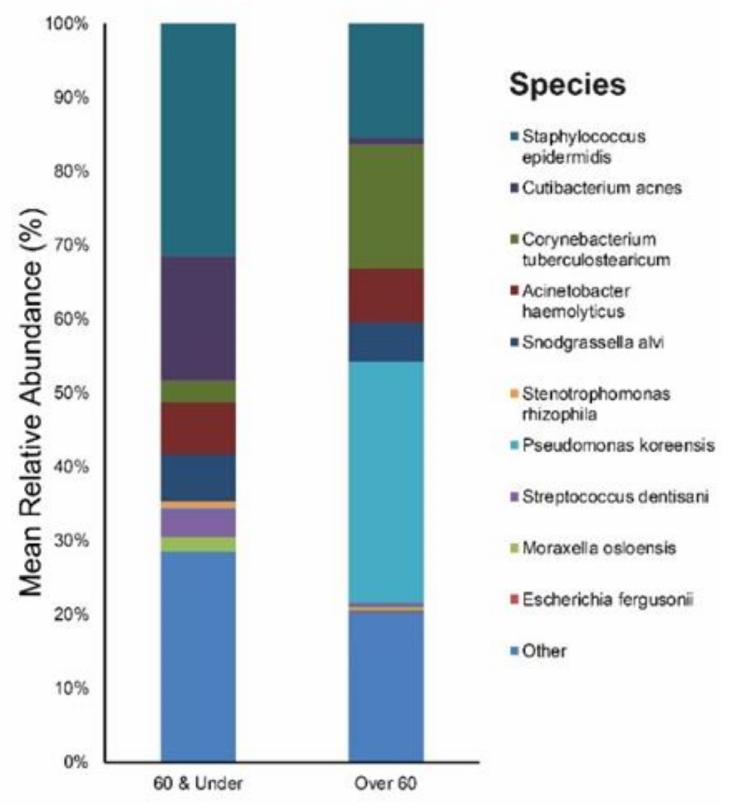
Figure 4. Bar graph on baseline skin microbiota in rosacea patients according to age (60 & Under, and Over